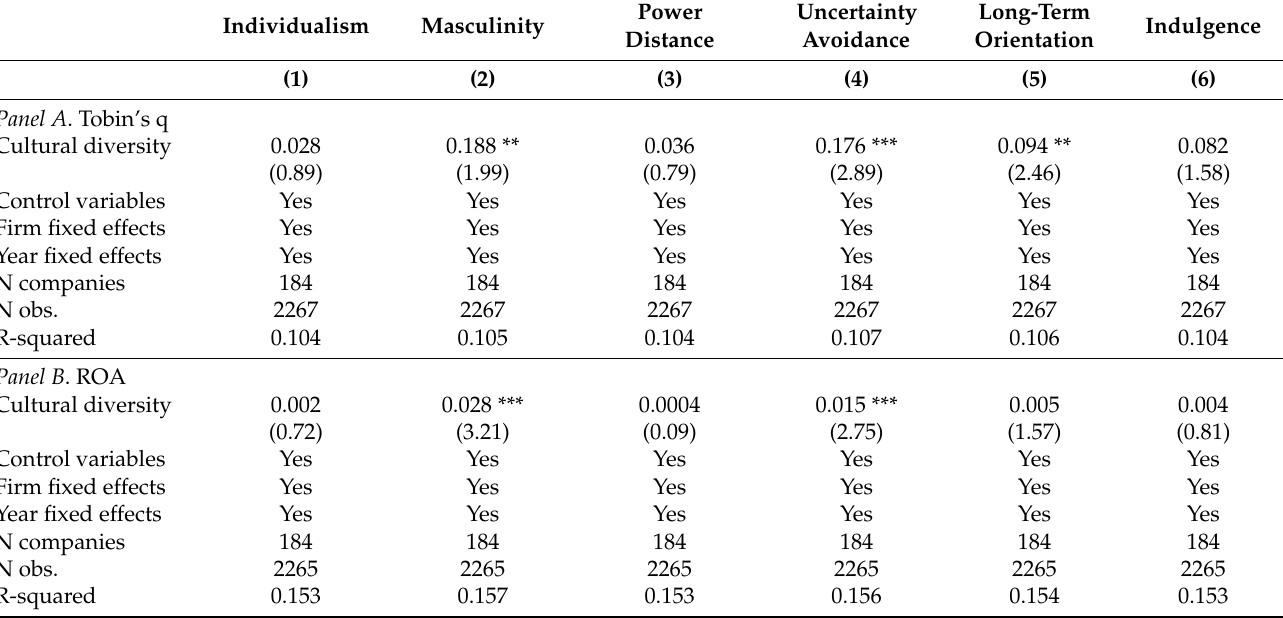
Table 8. Individual culture